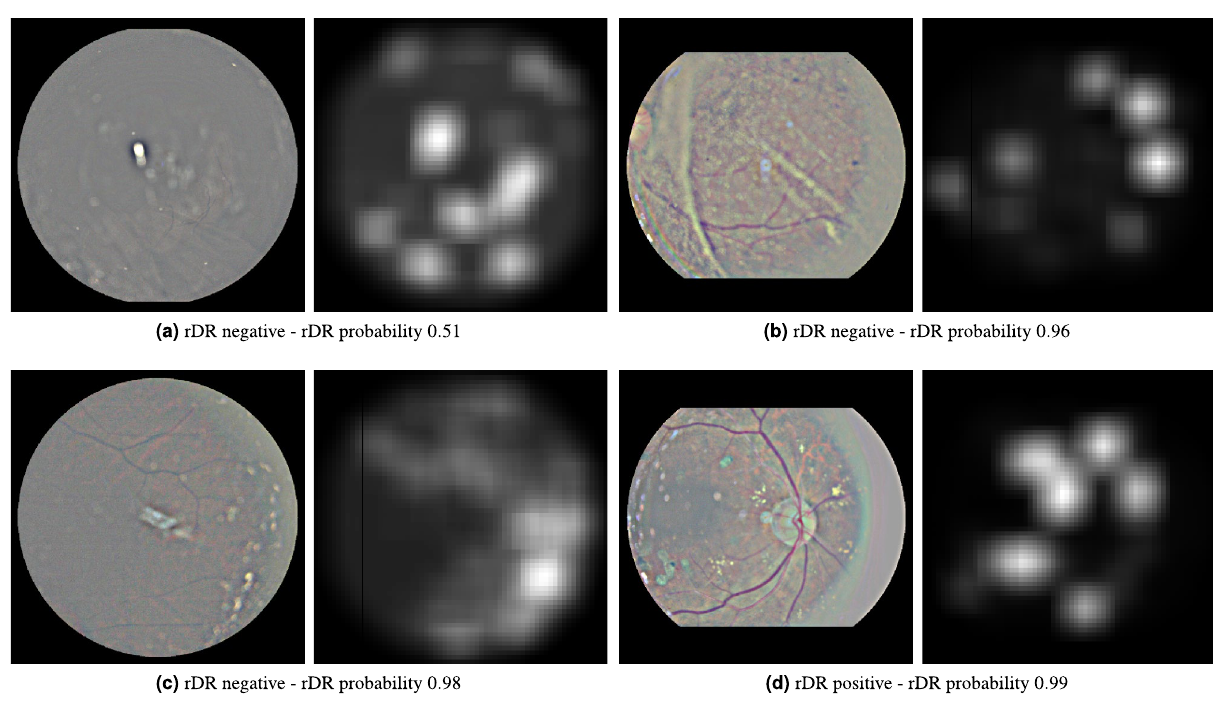
Figure 9. Visual examples of attention heatmaps for non-gradable (according to the estimates by Voets et al. 15 ) images of Kaggle-test. The proposed model achieved an AUC of 0.948 on the non-gradable subset of the Kaggle- test